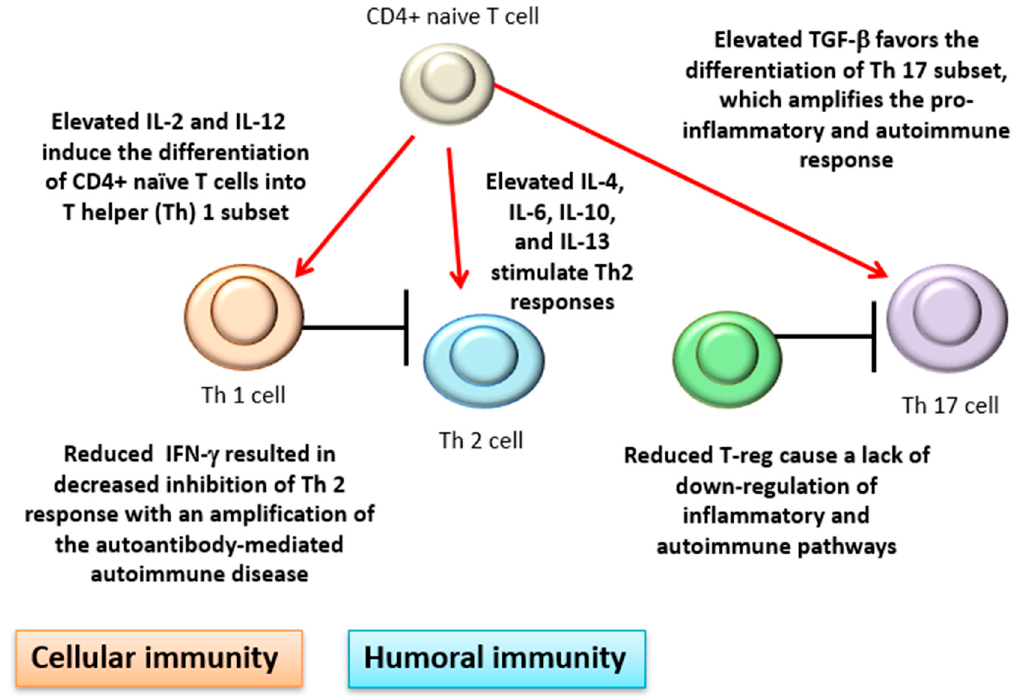
Figure 3. Cytokine dysregulation in AIHA. IL: interleukin; TGF- β : transforming growth factor β ; IFN- γ : interferon γ . Red arrows indicate stimulation black lines inhibition/block.